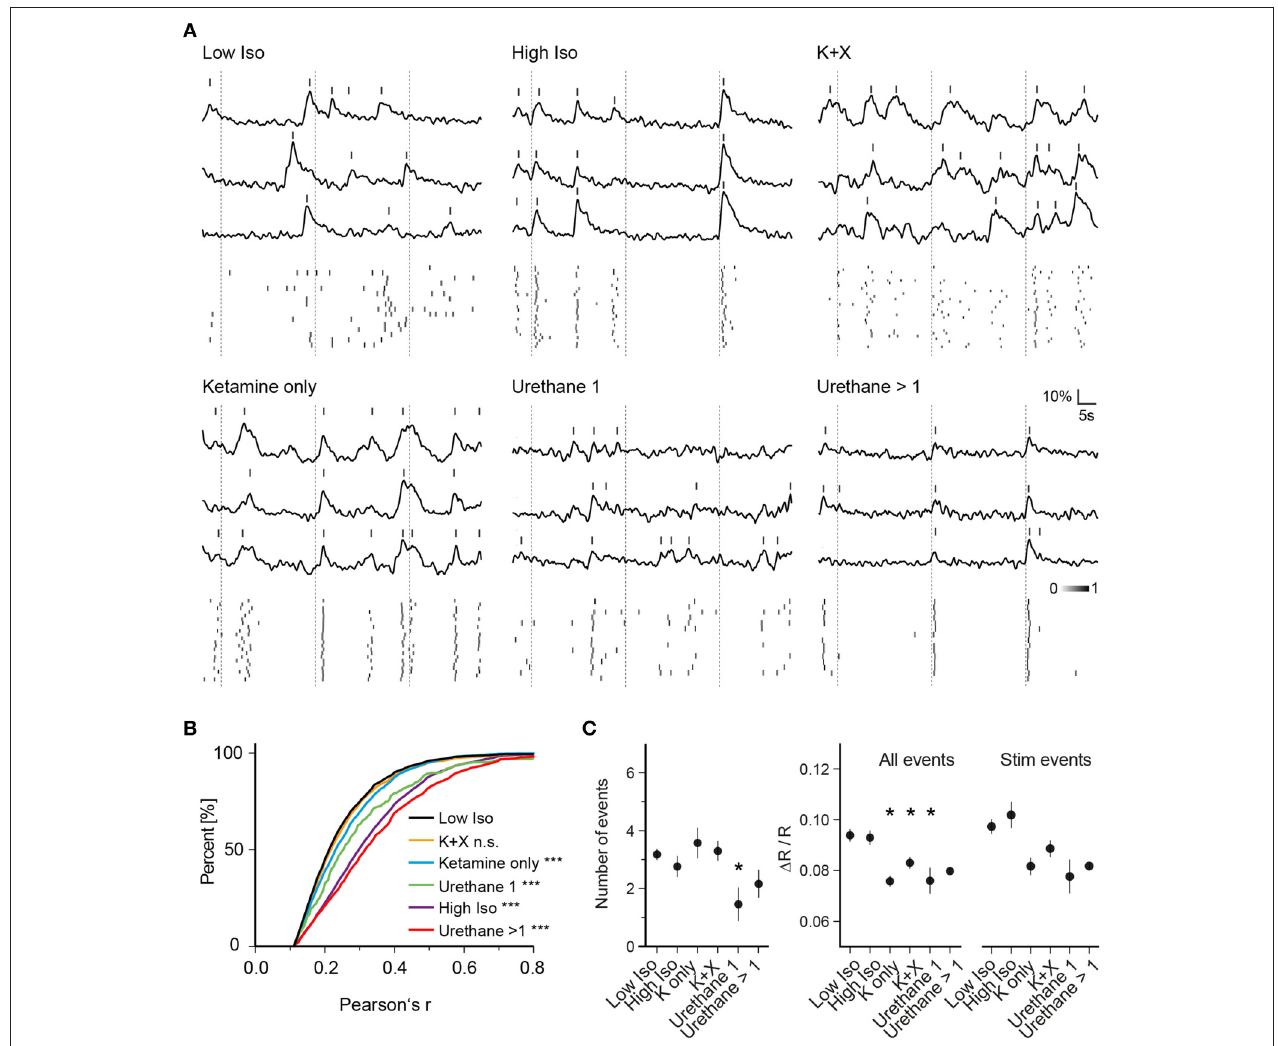
FIGURE 3 | Anesthesia-dependent synchrony is similarly induced by chemically distinct anesthetics. (A) Example traces of three cells for one trial of each anesthetic condition are shown. (Top) Ca 2 + signal traces; (Bottom) peak probability matrix. Dotted lines: time of air-puff stimulus (B) Cumulative frequency distributions of Pearson’s r over all cell pairs and trials. Values were pre-filtered for significance level of p < 0.05 as in Figure 2D (see Section Materials and Methods for details); the low isoflurane dataset is shown in black and is taken as baseline condition and as a reference for statistical testing. A substantial rise in correlation between cell pairs was observed for all anesthetic conditions except Ketamine + Xylazine (K + X) ( *** p < 0.001 for all datasets vs. Low Iso except K + X). (C) Mean number of events per trial, mean amplitude of all events per trial and mean amplitude of all stimulus evoked responses per trial over all trials are plotted (mean ± SEM, * p <